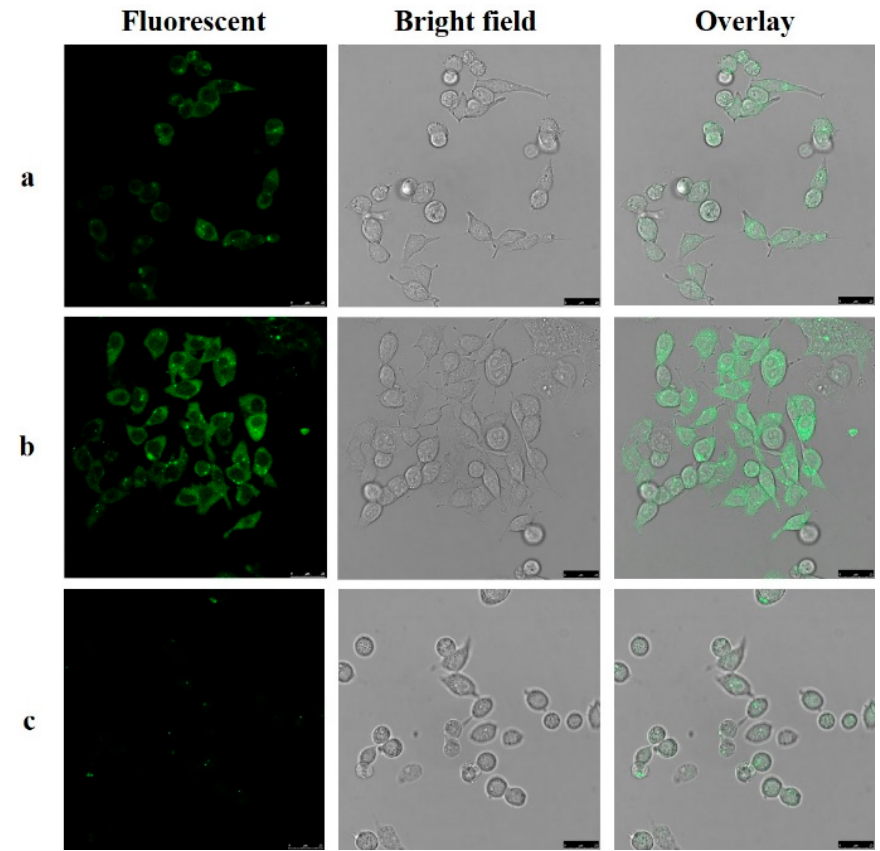
Figure 8. Fluorescent imaging of HepG2 cells: (Left) fluorescent image; (Middle) bright field image; and (Right) overlay image. λ ex = 405 nm, λ em = 420–480 nm. ( a ) Images of cells incubated with the probe (25 μ M) for 2 h at 37 °C; ( b ) Images of cells preincubated with Cys (100 μ M) for 1 h and then incubated